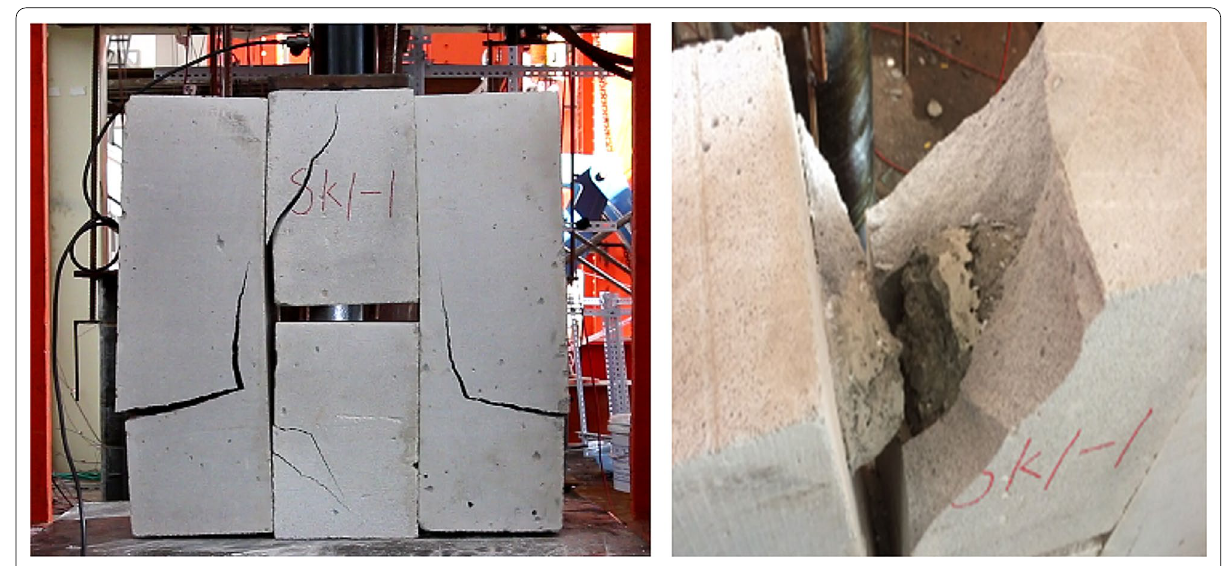
Fig. 9 Core-column concrete